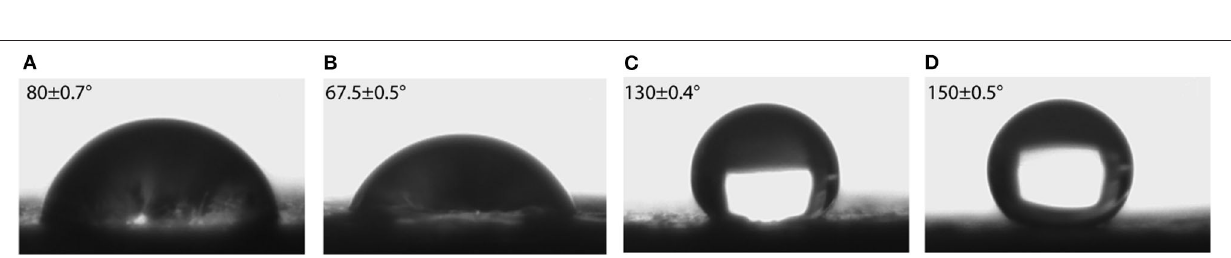
FIGURE 8 | Contact angle on steel and Gr-coated steel treated polymer binder. (A) Steel + binder, (B) steel + binder + solvent, (C) steel + binder + Gr, (D) steel + binder + Gr + THFS.